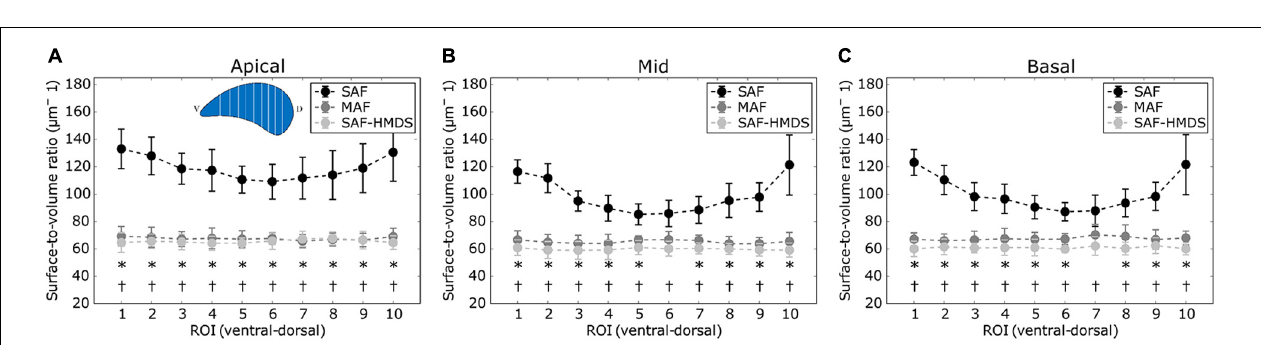
FIGURE 5 | Regional distribution of alveolar surface density in the ventral-dorsal direction for three regions of the lung: (A) apical zone, (B) mid zone, and (C) basal zone. Significant differences ( p -value ≤ 0.05) between the SAF and MAF, SAF and SAF-HMDS, and MAF and SAF-HMDS groups are indicated by ∗ , † , and #, respectively. Each ROI datapoint represents the mean ± standard deviation of n = 9 samples.